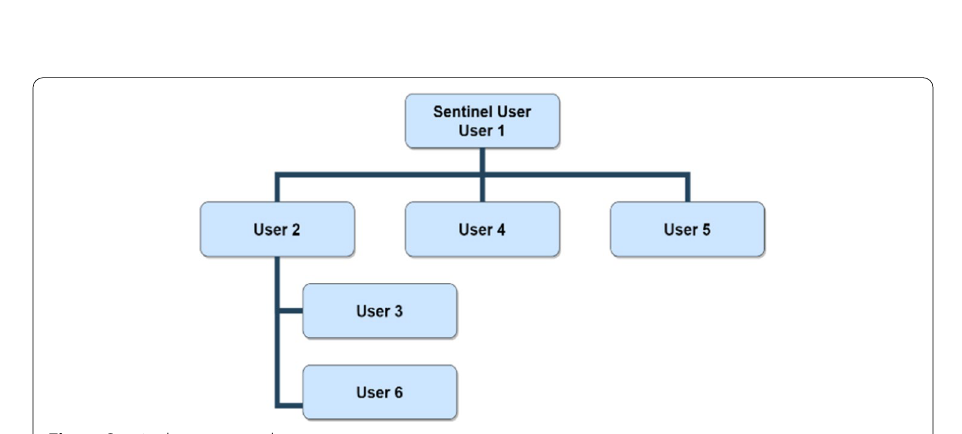
Fig. 5 Sentinel user on top